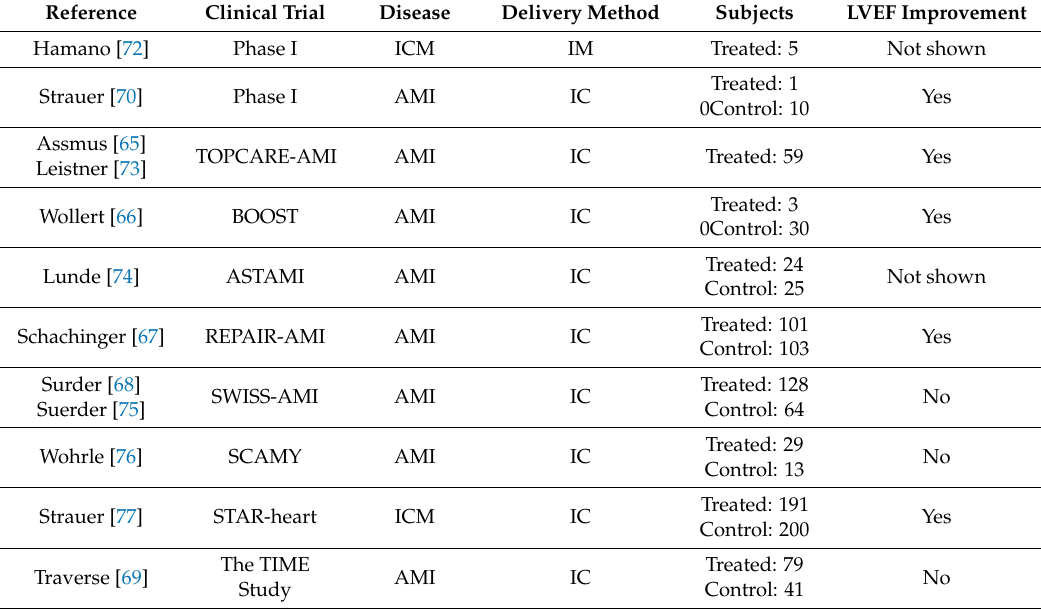
Table 3. Clinical trials with BMMNCs for cardiac